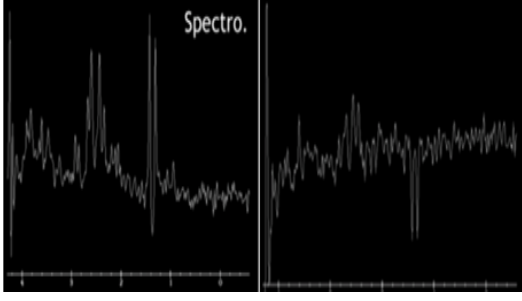
Figure 3. Cerebral proton magnetic resonance spectroscopy (Spectro) for cerebral hydatid cyst: low levels of NAA and creatine, and peaks of lactate and pyruvate.